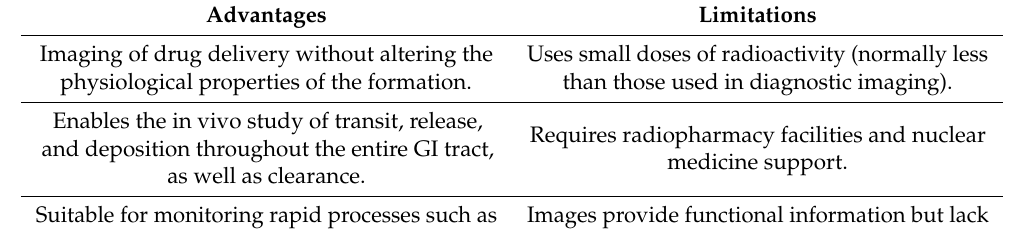
Table 1. Advantages and limitations of scintigraphy.